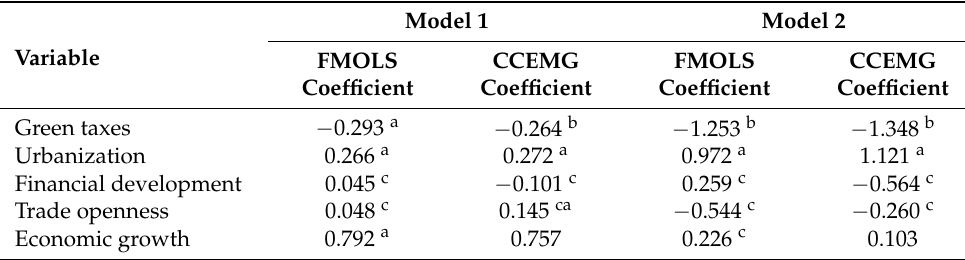
Table 6. FMOLS and CCEMG estimators for robustness check.